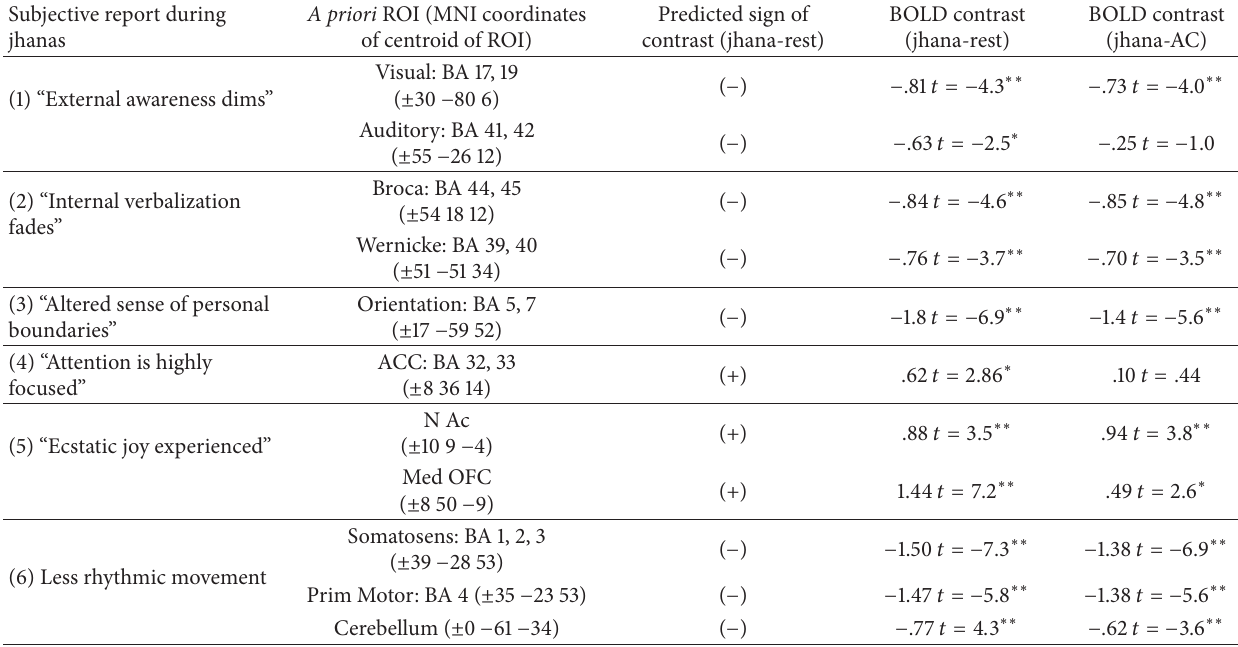
Table 1: Mean percent BOLD signal change in a priori defined ROIs related to 6 hypotheses on jhana activity contrasted with rest and AC meditation, followed by its two-sided 𝑡 test (corrected for multiple comparisons). Contrasts labeled simply “jhana” refer to the pooled activity over all recorded jhanas 2–5. All 22 planned contrasts are in the predicted direction.